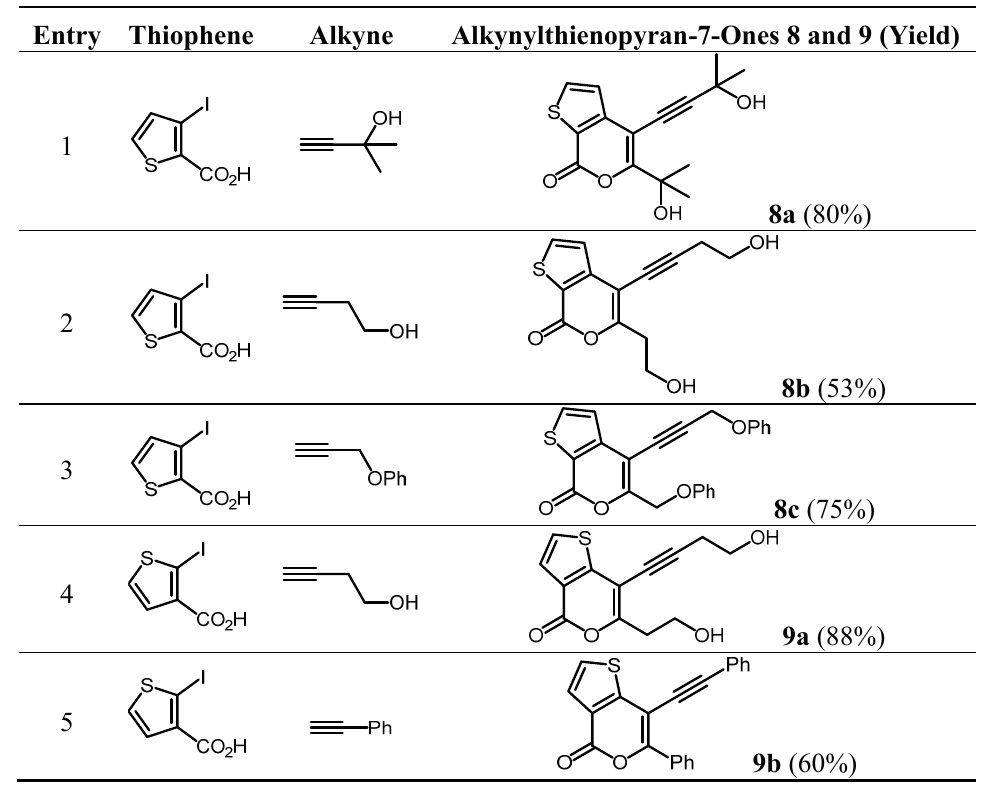
Table 1. Selected 4-alkynylthieno[2,3- c ]pyran-7-ones 8 and 7-alkynylthieno[3,2- c